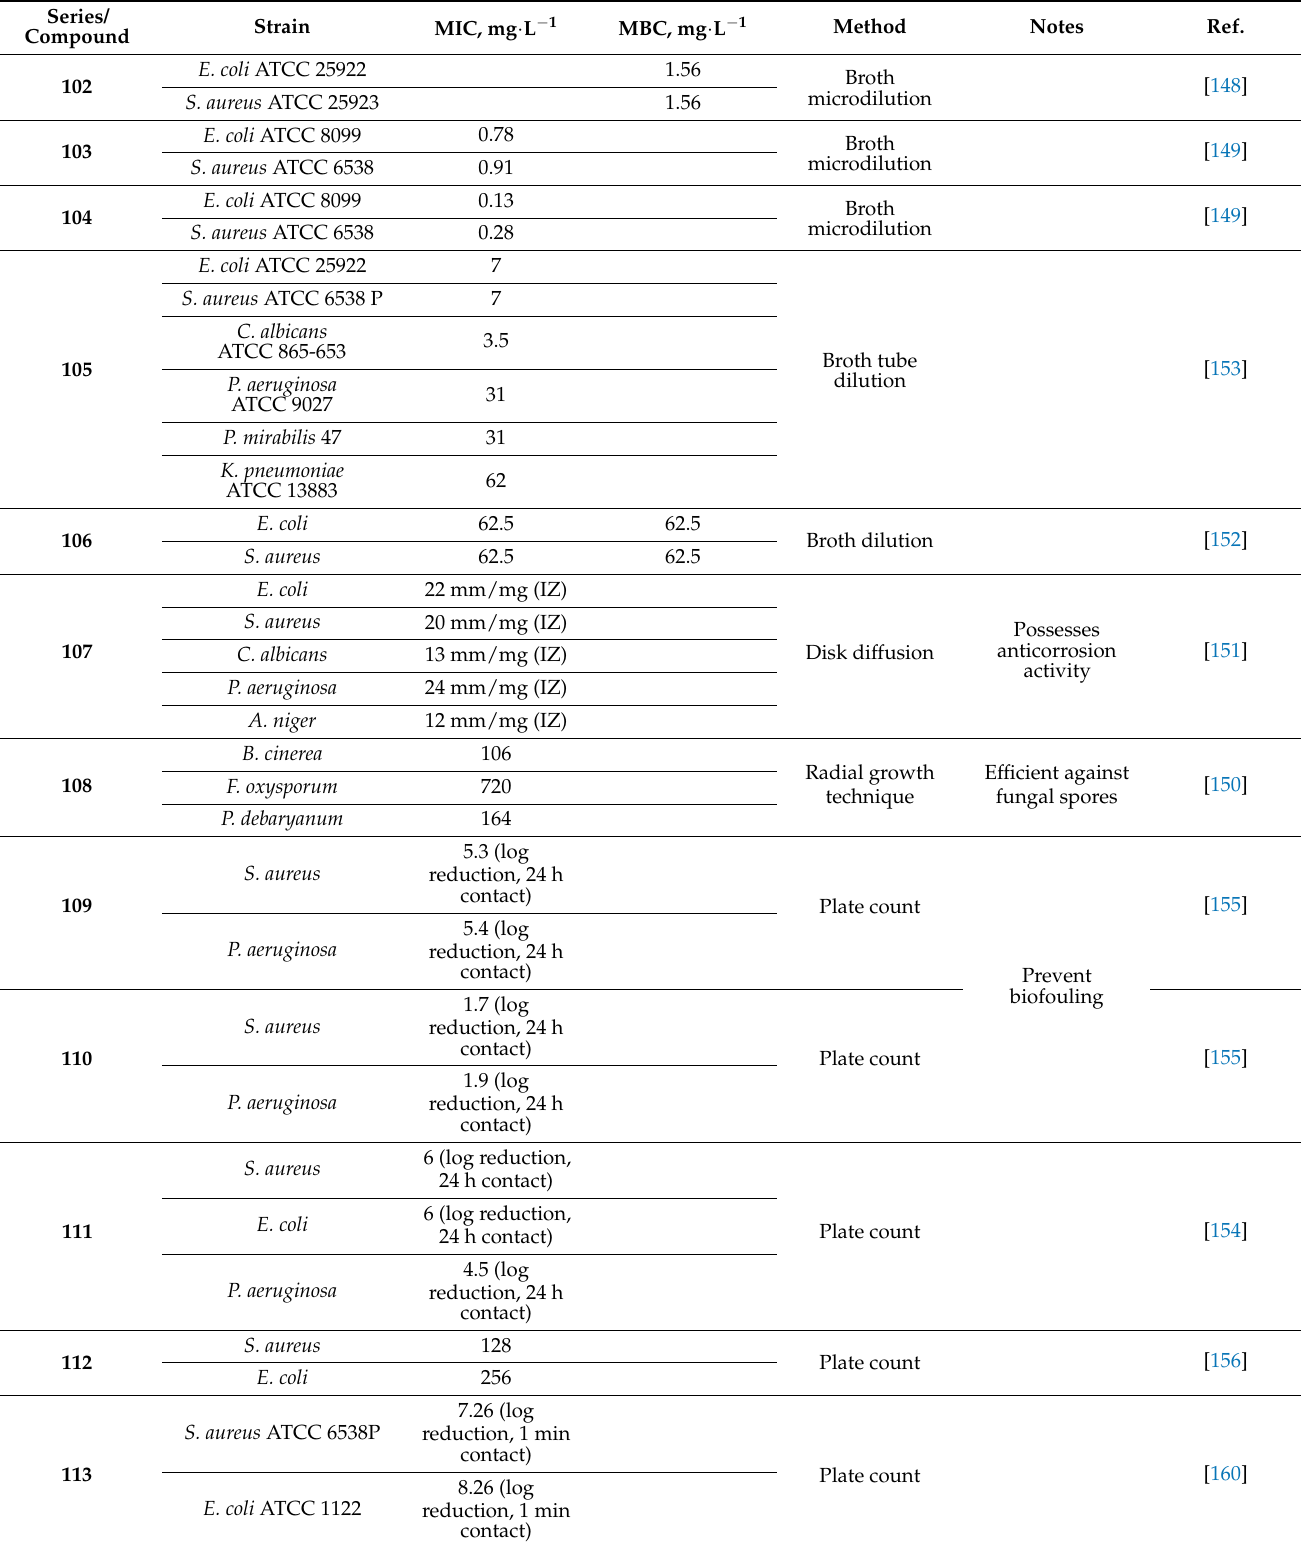
Table 7. Antimicrobial activity of poly-QACs